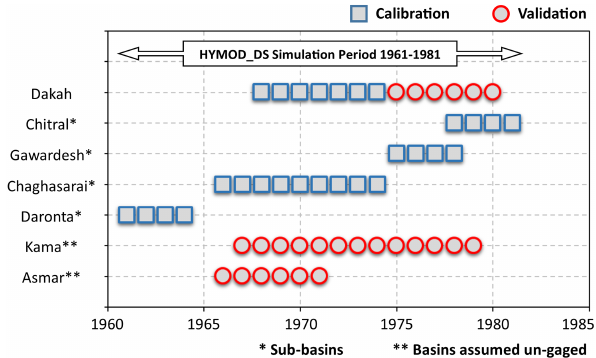
Figure 2. Streamflow data usage for the model calibration and val-